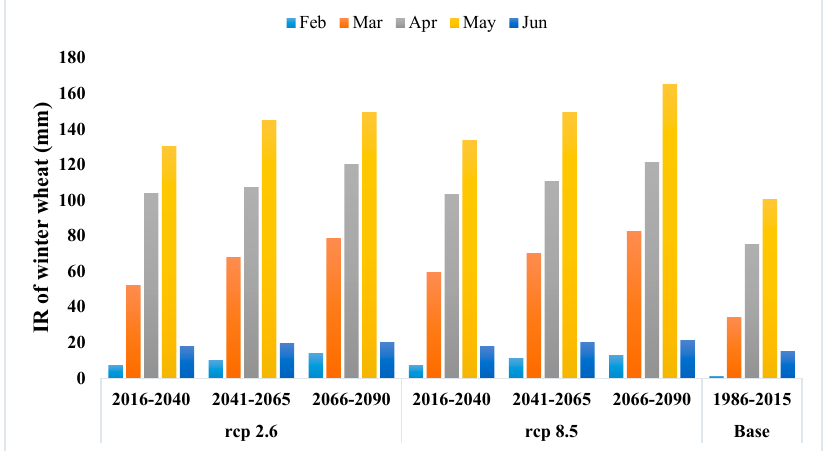
Figure 4. Comparison of the irrigation water requirement (IR) of winter wheat under scenarios rcp2.6 and rcp8.5 for the periods 2016–2040, 2041–2065, and 2066–2090 with the baseline period.